Question: Briefly state, in one sentence, what is plotted here.
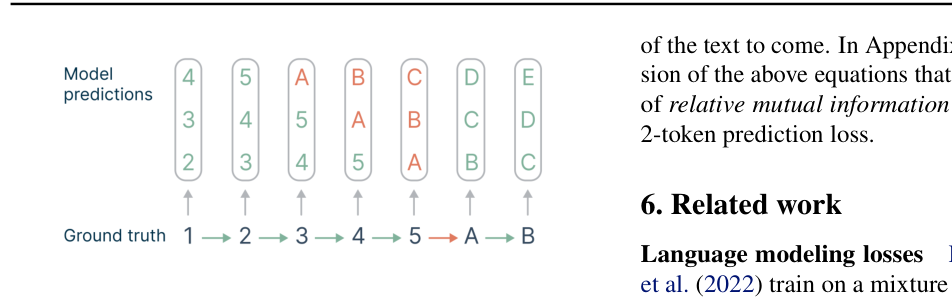
Answer: Multi-token prediction loss assigns higher im- plicit weights to consequential tokens. Shown is a se- quence in which all transitions except “5 →A” are easy to predict, alongside the corresponding prediction targets in 3-token prediction. Since the consequences of the difficult transition “5 →A” are likewise hard to predict, this transi- tion receives a higher implicit weight in the overall loss via its correlates “3 →A”, ..., “5 →C”.